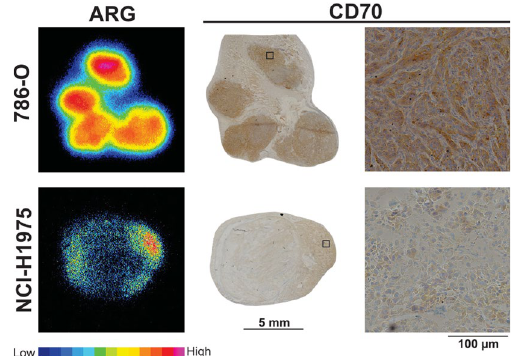
Fig. 4 Ex vivo analysis of 786-O and NCl-H1975 tumors. Representative autoradiography (ARG) and microscopy images of adjacent histologic tumor slices stained for CD70 using a biotinylated anti-CD70